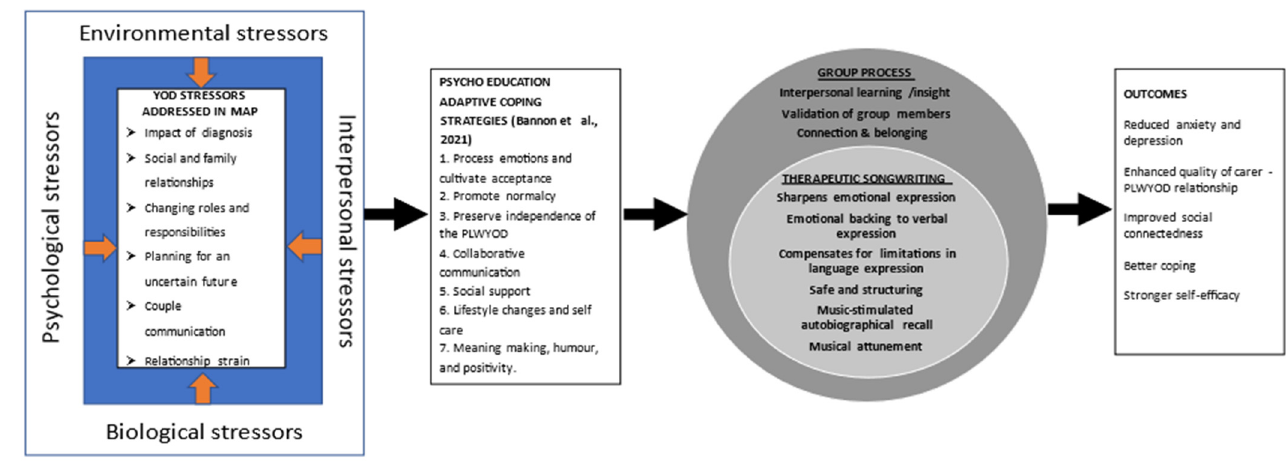
Figure 2. The theoretical framework, based on Bannon et al. (2021) (PLWYOD people living with younger-onset dementia).